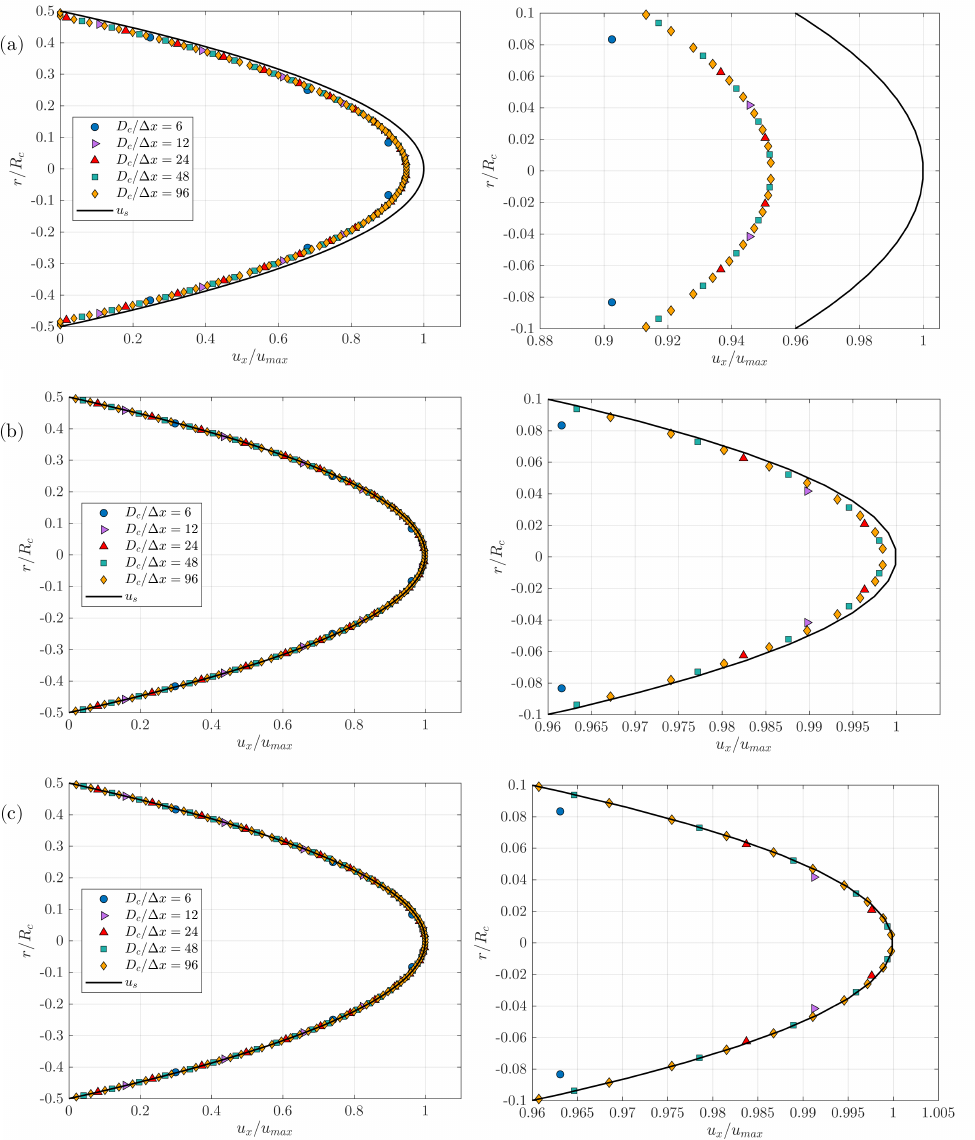
Figure 7. Influence of the grid refinement D c / ∆ x = 6,12,24,48 and 96 on the convergence of the velocity profiles: ( a ) D c / ∆ c t = 6, ( b ) D c / ∆ c t = 24, ( c ) D c / ∆ c t =